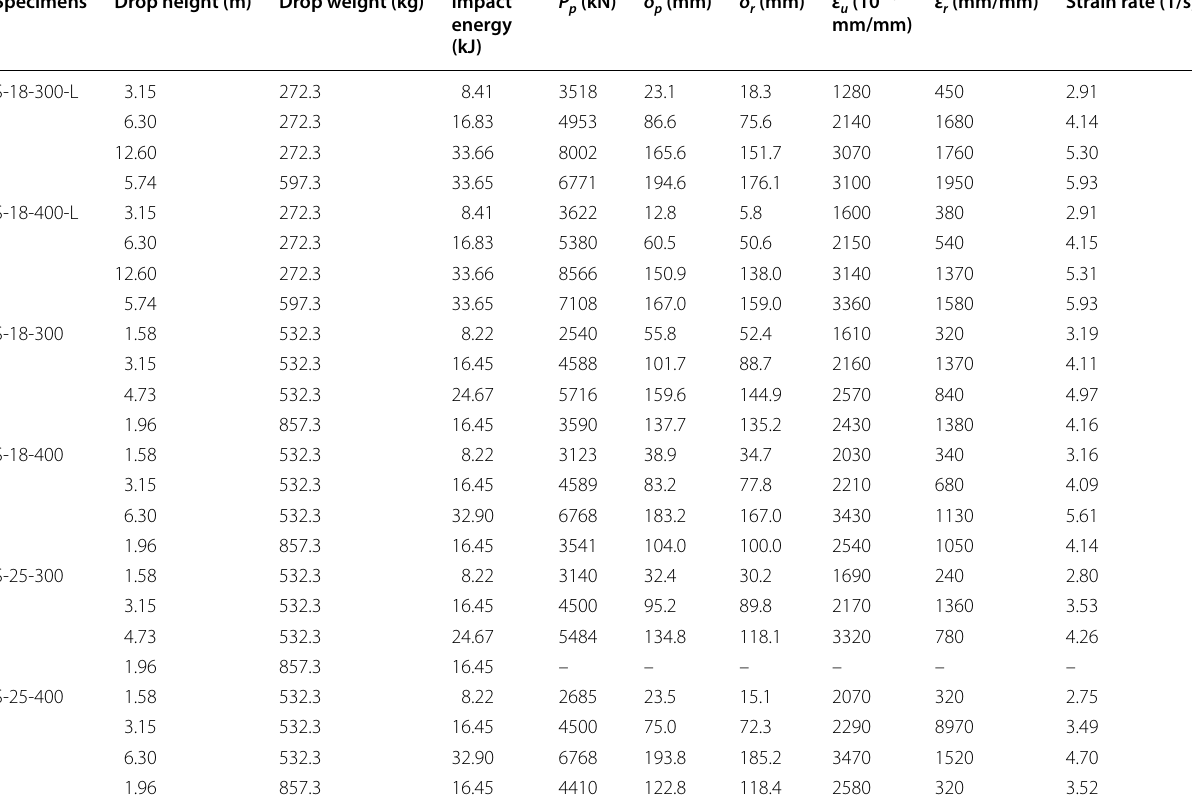
Table 2 Summary of test